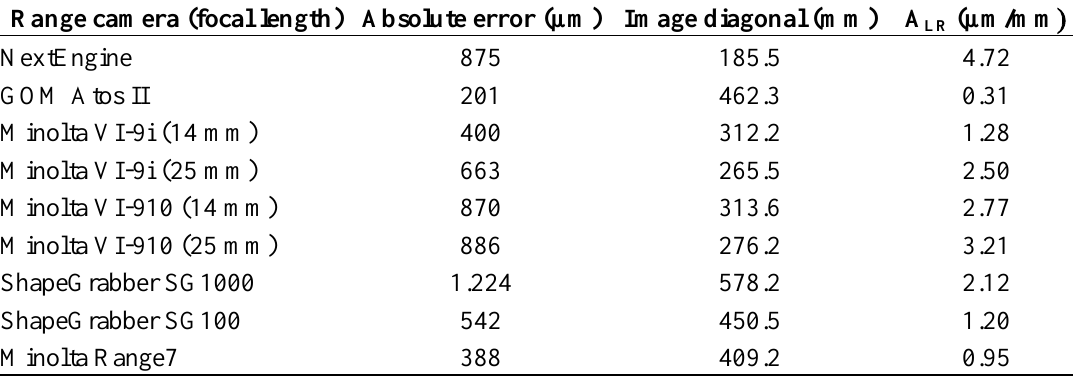
Table 5. Relative linear accuracy evaluated on the range devices under